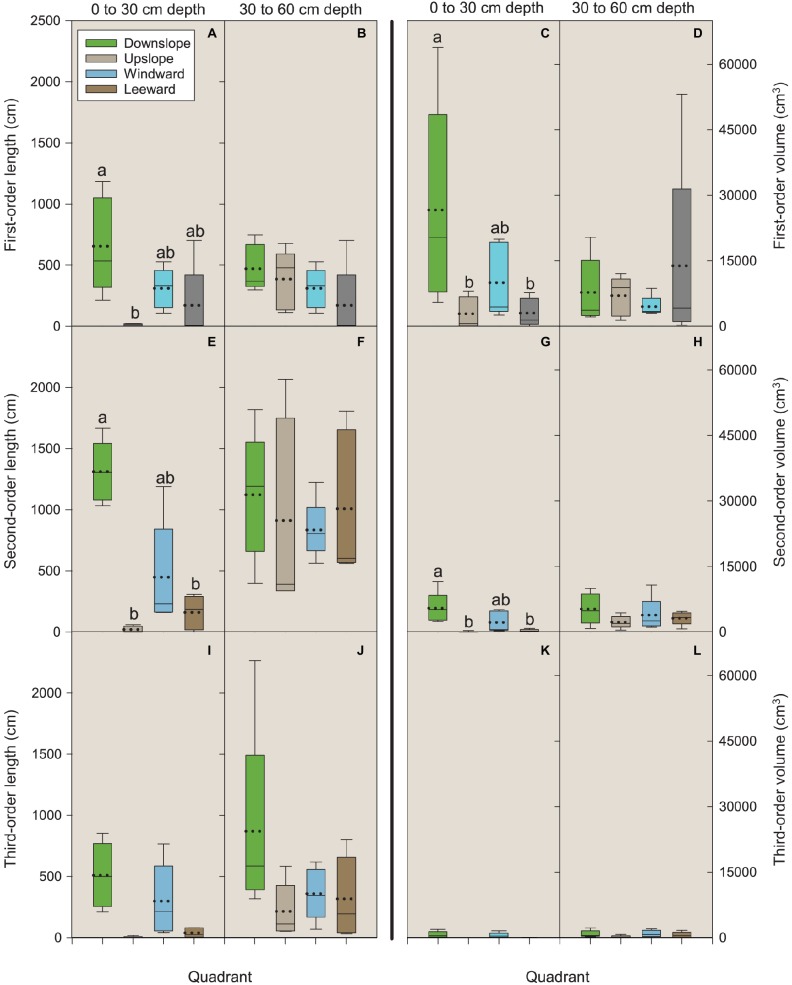
Length and volume of first-, second-, and third-order roots by quadrant and soil depth (0–30 and 30–60 cm). Each depth was analyzed independently. Letters within each order, variable, and depth combination indicate significant differences (p < 0.05); absence of letters reflects that no significant difference was detected. Vertical boxes represent approximately 50% of the observations and lines extending from each box are the upper and lower 25% of the distribution. Within each box, the solid horizontal line is the median value and the dotted line is the mean.